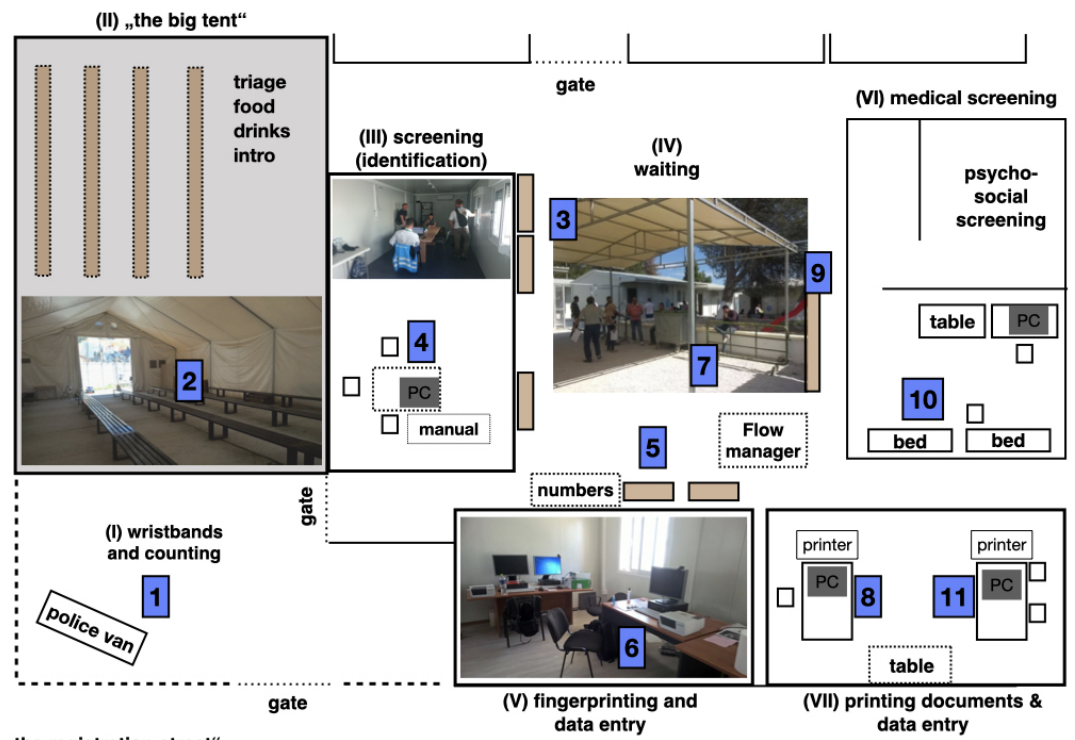
Figure 2. Situational map of the Registration and Identification Centre